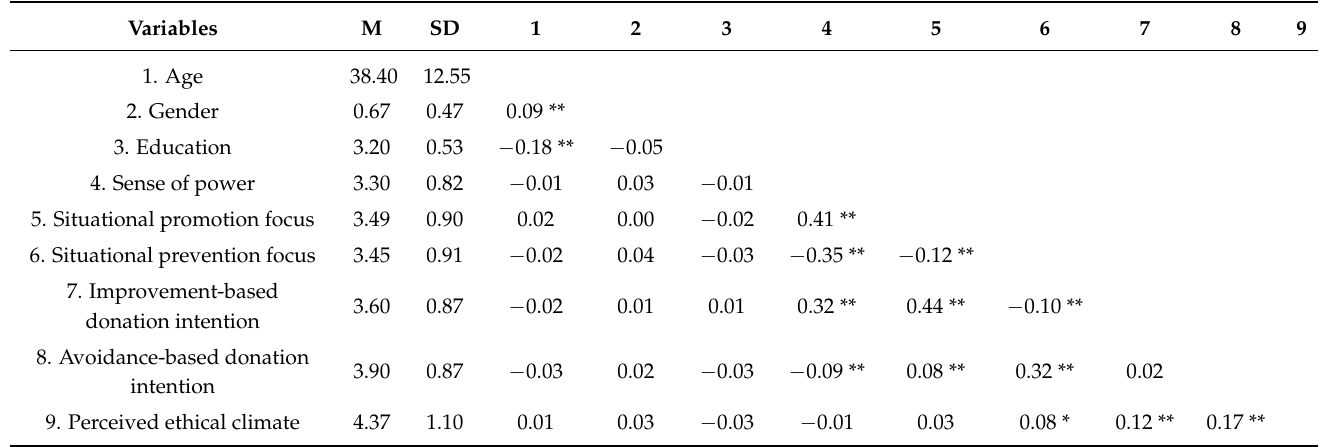
Table 1. Means, standard deviations, and correlations.